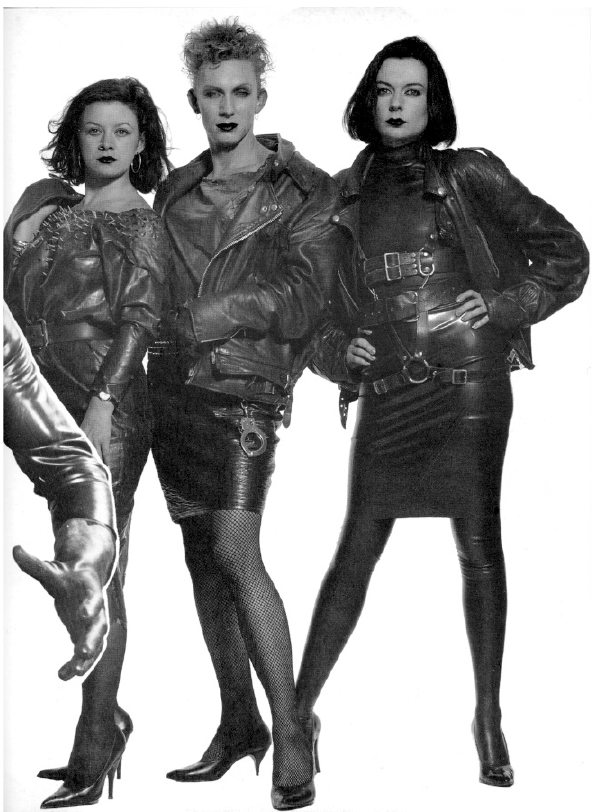
Figure 5. Unknown, Antal Nemeth and Jill Westwood, posing for the book The Black Leather Jacket written by English journalist and author Mick Farren in 1985 (p. 65).